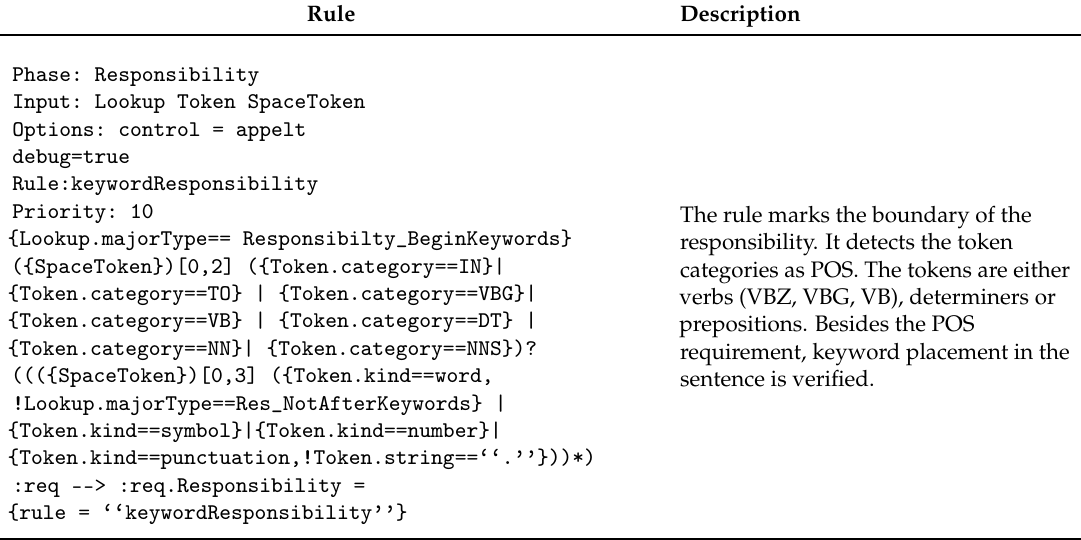
Table 7. Sample rule for job description responsibility detection using JAPE in SAJ. Rule Description